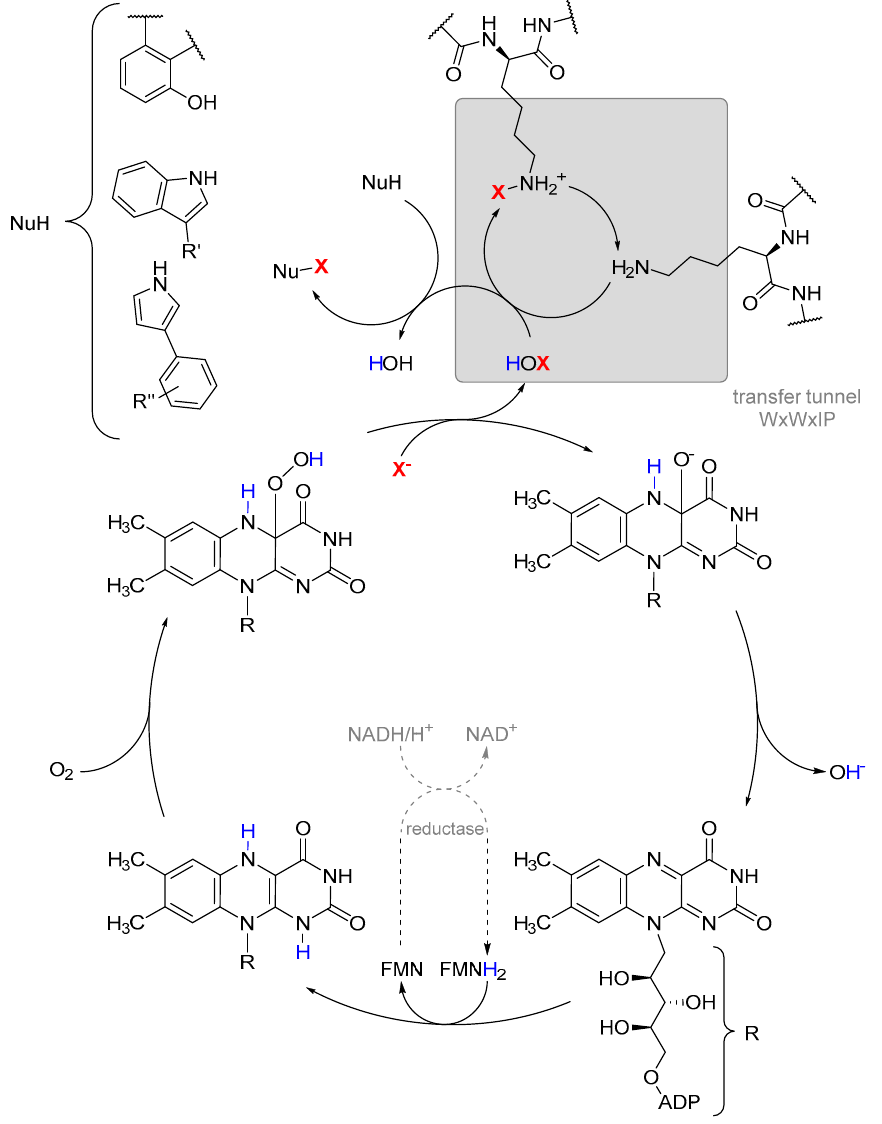
Figure 15. Catalytic cycle of halogenation by flavin-dependent halogenases [96,115].